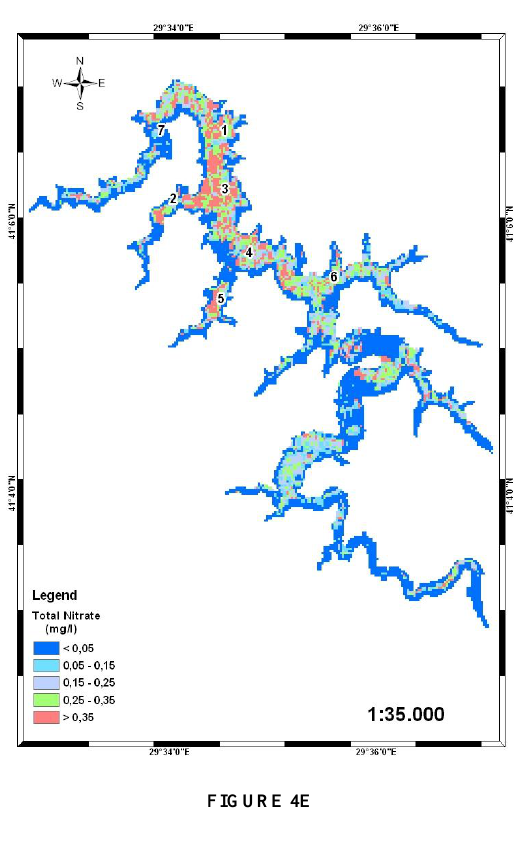
Multitemporal WQ